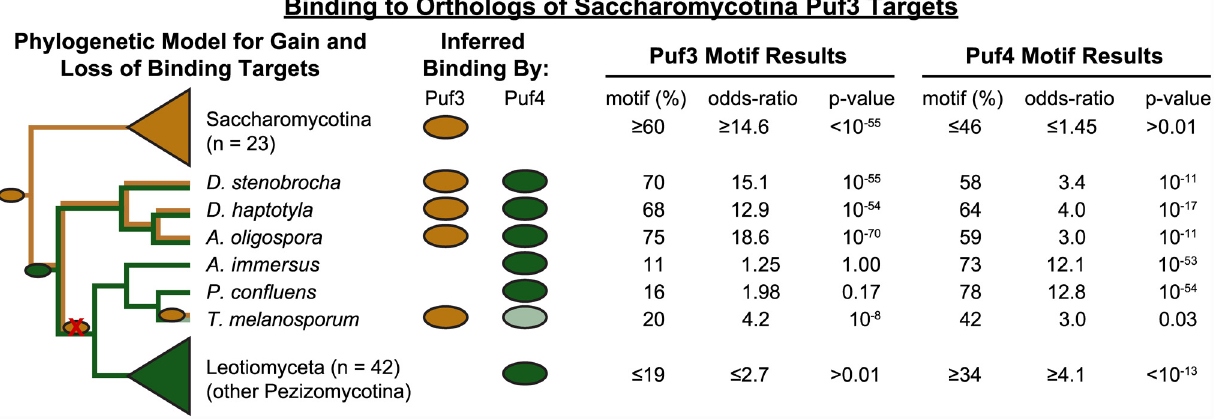
Fig 6. Inferring when Puf4 acquired RNA targets related to Saccharomycotina Puf3 targets. Prevalence of putative Puf3 and Puf4 binding sites in the orthologs of Saccharomycotina Puf3 targets in early diverging Pezizomycotina species. A putative binding site is inferred based on the presence of sequences matching the Puf3 or the Pezizomycotina Puf4 motif. Listed under motif results is the percentage of RNAs with a binding site sequence in the 3' UTR. The odds-ratio represents the enrichment of orthologs of Saccharomycotina Puf3 target RNAs containing a binding site sequence compared to the prevalence in all other RNAs. The p -value was computed using Fisher's exact test and was Bonferroni corrected. A colored oval in the "Inferred Binding By" column indicates significant enrichment of Puf3 or Puf4 sites in each species. The light green oval for Puf4 indicates borderline significance. The cladogram on the left represents a parsimonious model with color along a branch indicating the binding of Puf3 (gold) or Puf4 (green) to the orthologs of Saccharomycotina Puf3 targets (see S21 Fig for an alternative model). A colored oval within the cladogram denotes a gain in binding, and a red X over an oval denotes a loss of binding. Literature results were used to derive the relationships of species within Orbiliomycetes [86,87] and Pezizomycetes [88 –